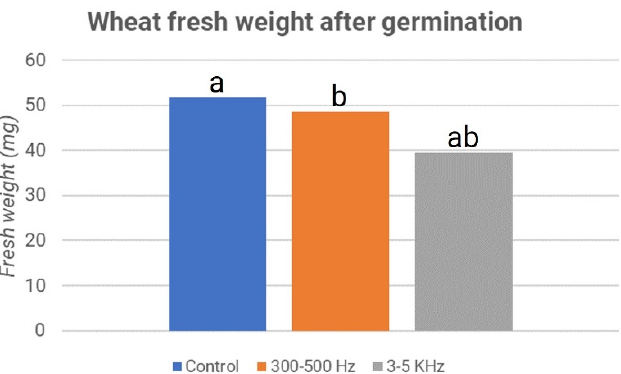
Figure 11. Lentils’ fresh weight after germination: third experiment. The letters “a” and “b” refer to the statistical significance of the observed difference between sample couples with a p -value < 0.05 and n = 160.